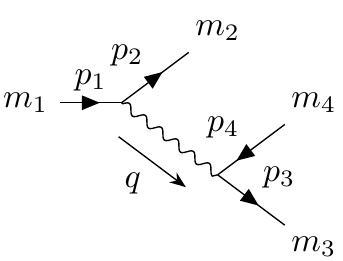
Figure 15. Feynman diagram for a general decay process via an o(cid:11)-shell